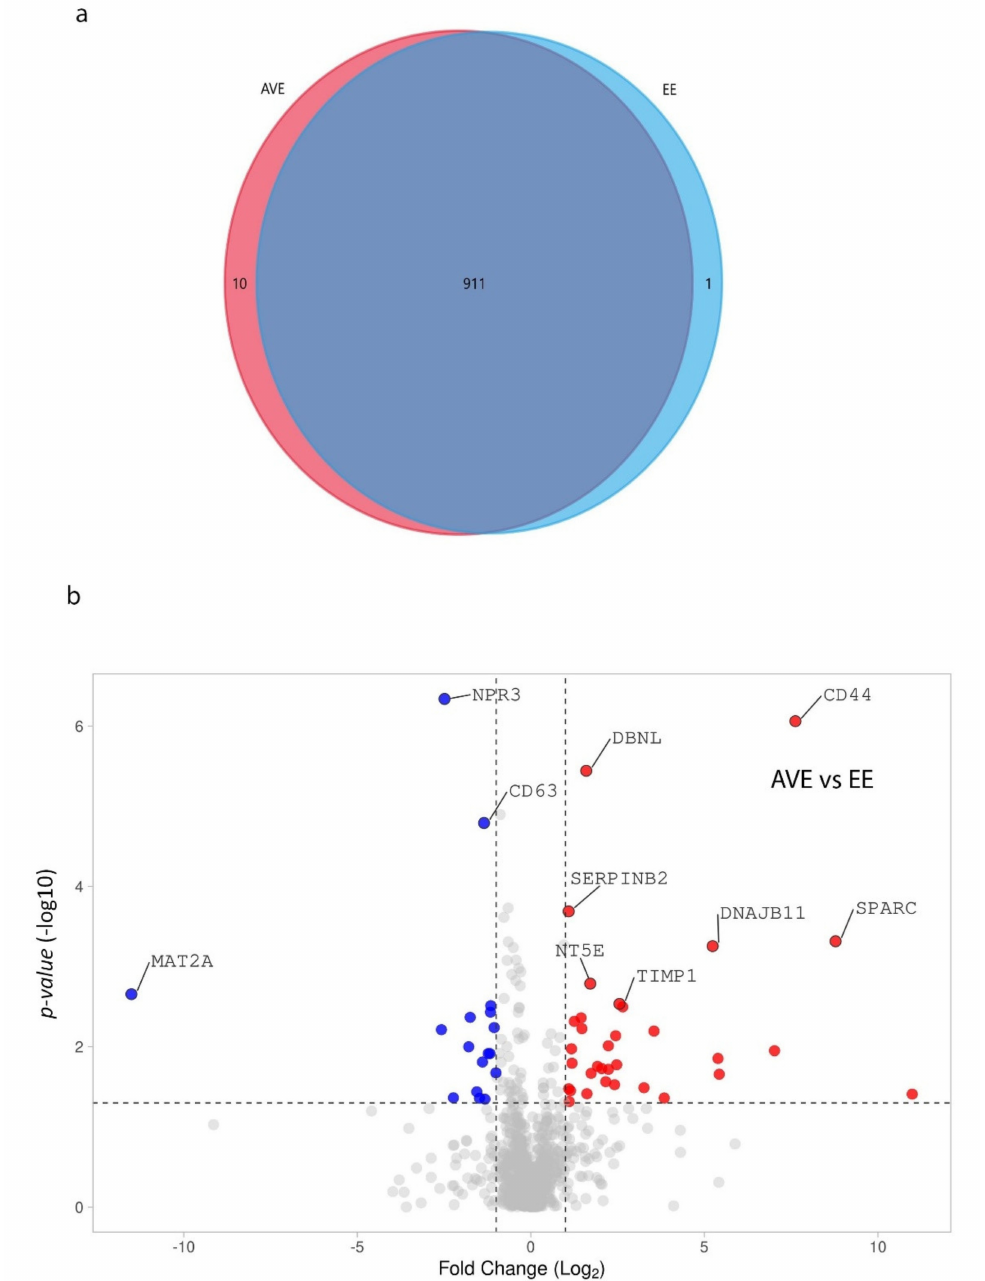
Figure 1. Venn diagram represents ( a ) the distribution of all detected proteins in aortic valvular endothelium (AVE) and endocardial endothelium (EE). The volcano plot represents ( b ) differentially expressed proteins in AVE cells compared to EE cells. The Student’s t -test was used for the differential expression analysis using Progenesis QI for Proteomics. Proteins with a raw p -value < 0.05 and fold change > 2 were highlighted in the figure (Red—upregulation and